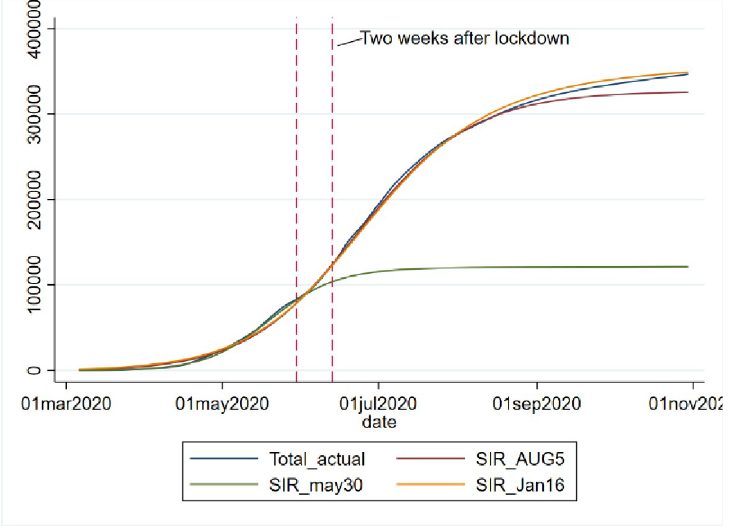
Fig 5. Impact of easing lockdown measures on COVID-19 epidemic in